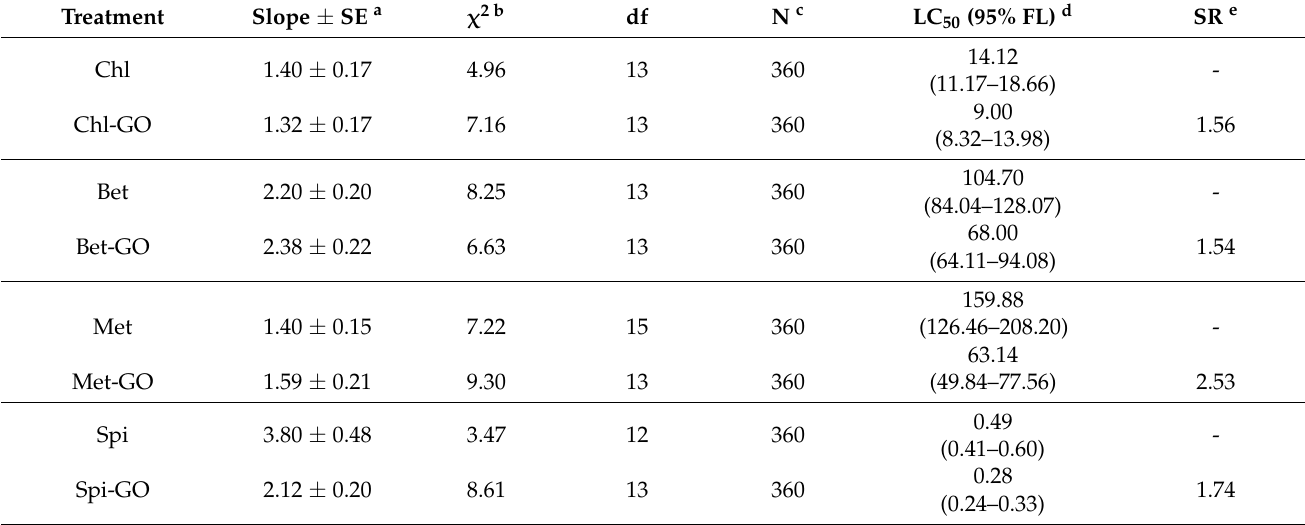
Table 3. Synergistic effect of GO on four pesticides against the third instar larvae of S. frugiperda at 48